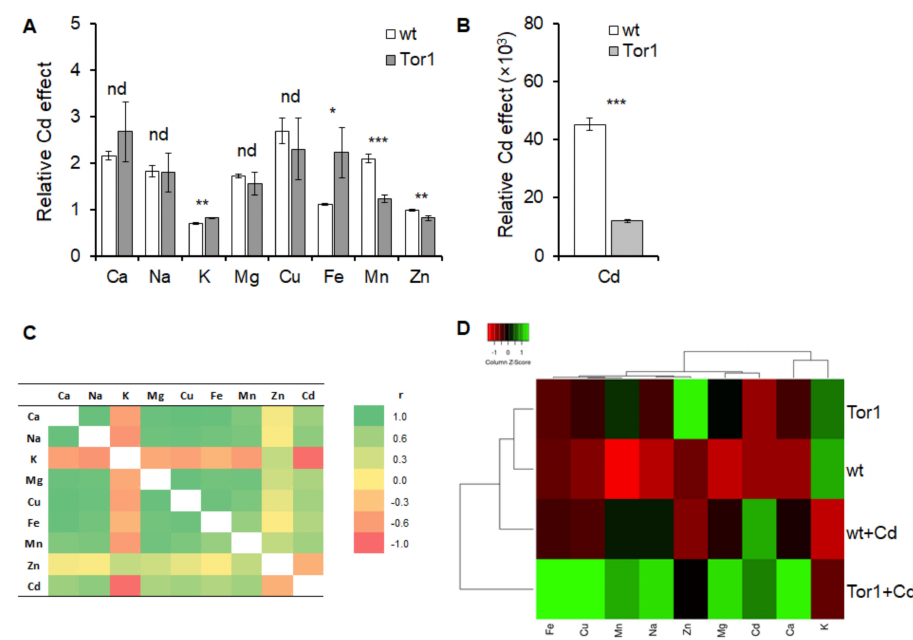
Figure 7. The e ff ect of Cd supplementation on wild-type and Tor1-null cells ionome. ( A ) Changes in the mineral elements content after Cd treatment expressed as ratio of the respective untreated strain shows that the increase in Ca 2 + , Na + , Mg 2 + , and Cu 2 + levels is comparable among the two tested strains, whereas the increase in Mn 2 + and Zn 2 + and in the wild-type (wt, white bar) strain is significantly higher compared to the Tor1-deficient (Tor1, grey bar) cells, while the decrease in the K + levels and the increase in the Fe 3 + amounts are significantly higher in the Tor1 strain. ( B ) Cd content in WT and Tor1 cells expressed as the ratio of the respective untreated strain. Statistical significance is specified by Duncan´s post-hoc test, expressed by asterisks (*) and shown as p < 0.05 *, 0.01 **, 0.001 *** nd above the bar indicates that the two mean values are not significantly di ff erent; individual bar represents the mean ± SD ( n = 4). ( C ) Correlation analysis showing mutual correlations of tested mineral elements, ranging from a highly positive Pearson´s correlation coe ffi cient (r = 1) to a highly negative correlation coe ffi cient (r = − 1). ( D ) Data-driven heatmap expresses a range of values which show mutual correlations of data clusters established from each tested condition and the ion content in relation to the